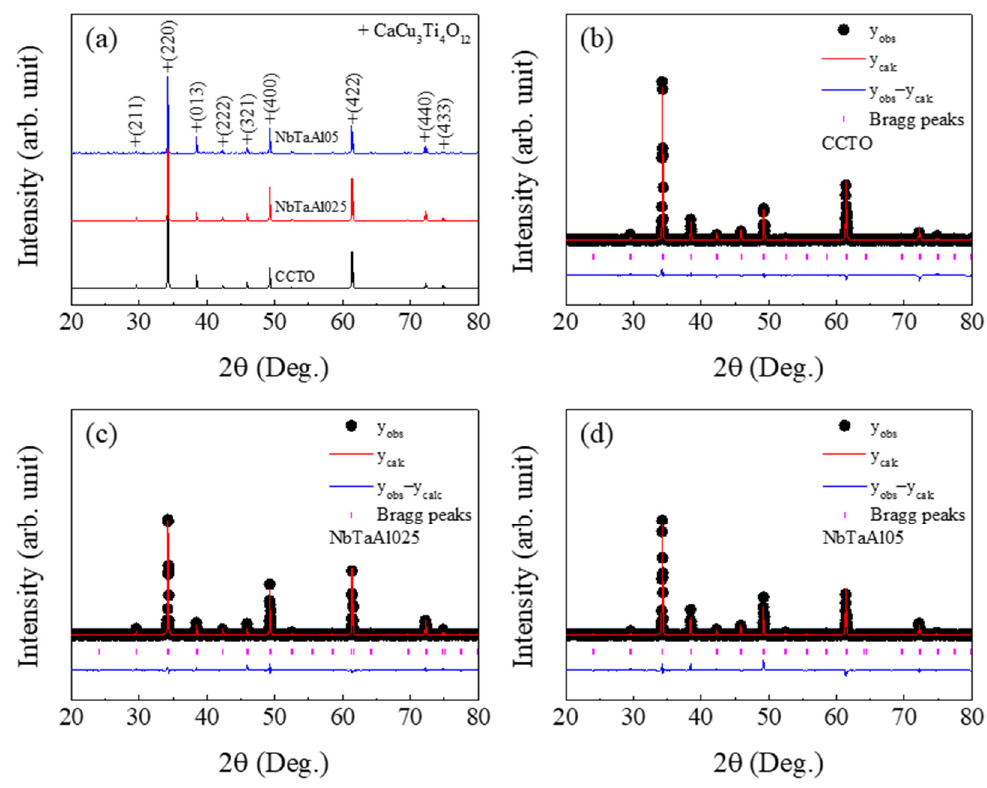
Figure 1. ( a ) XRD patterns of the CCTO, NbTaAl025, and NbTaAl05 ceramics. ( b – d ) The Rietveld profile fits of the CCTO, NbTaAl025, and NbTaAl05 ceramics, respectively.